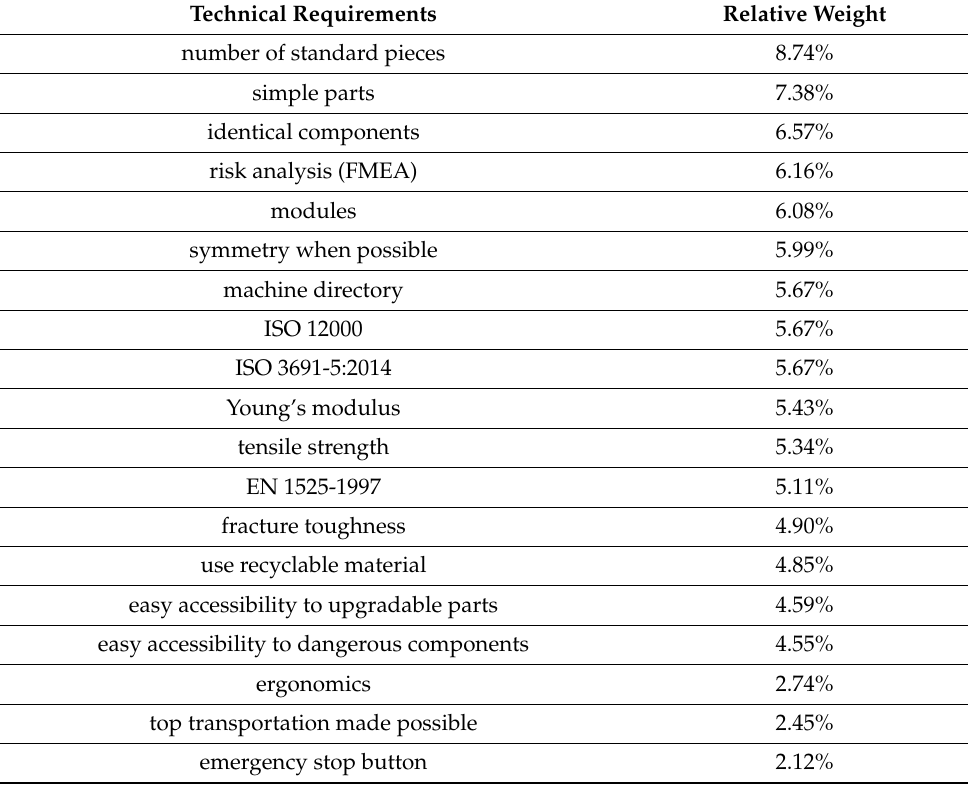
Table 5. Additional requirements combined results.